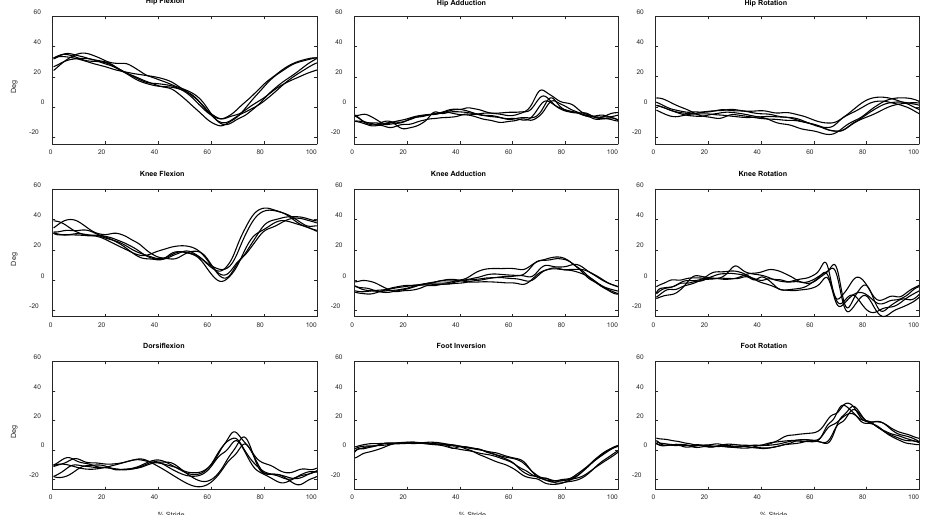
Figure 4. Exemplar 3D lower limb joint angles during five skating trials of a participant obtained from IMU readouts.